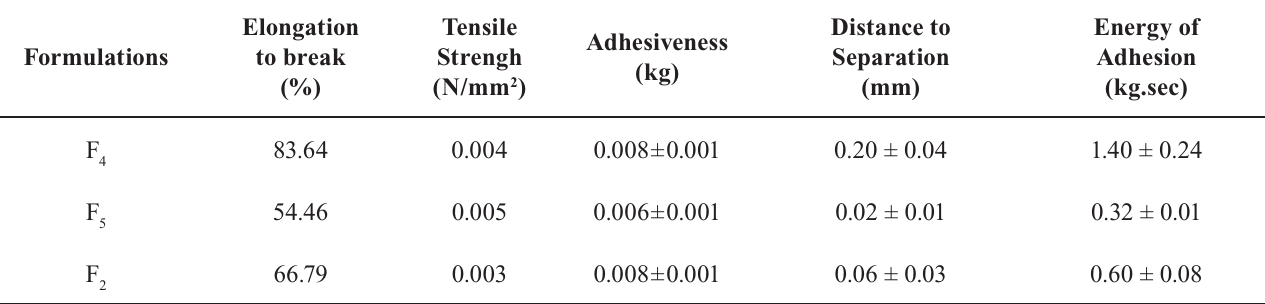
TABLE V - Mechanical and adhesion properties of different patches with different adhesives. Results are expressed in Mean ± SEM with n=6